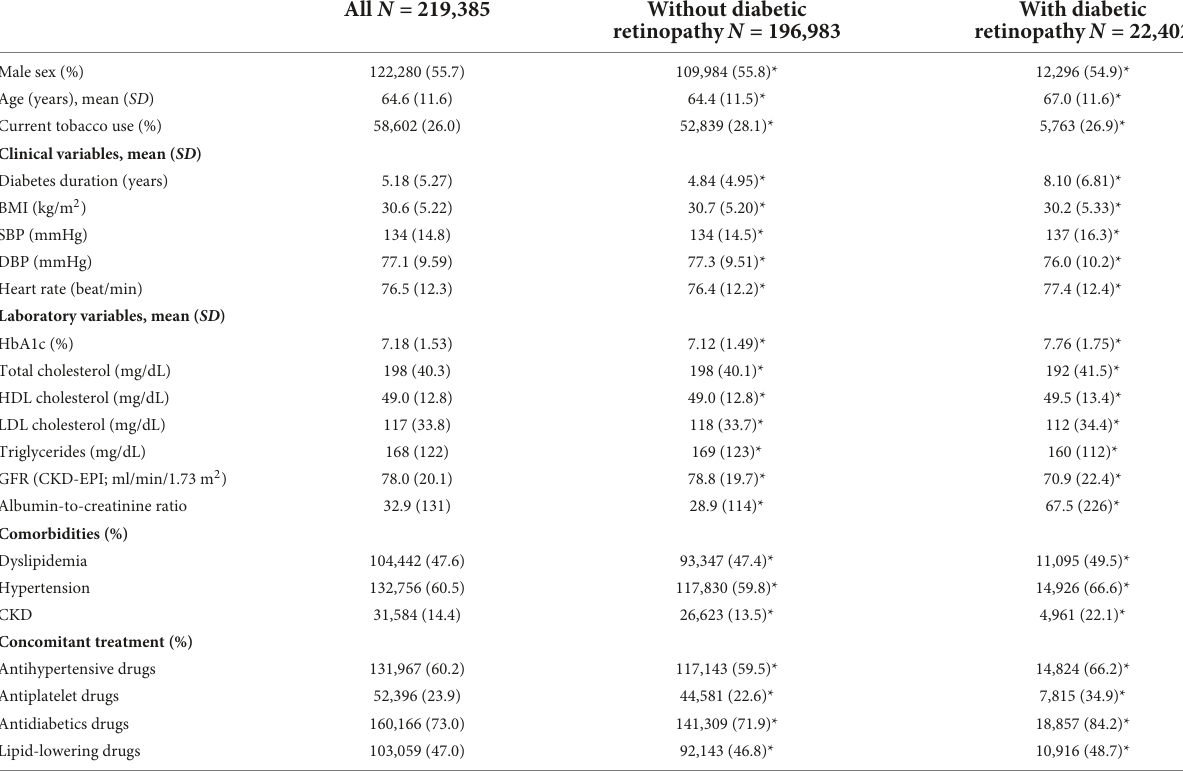
TABLE 1 Clinical characteristics of the subjects at inclusion.